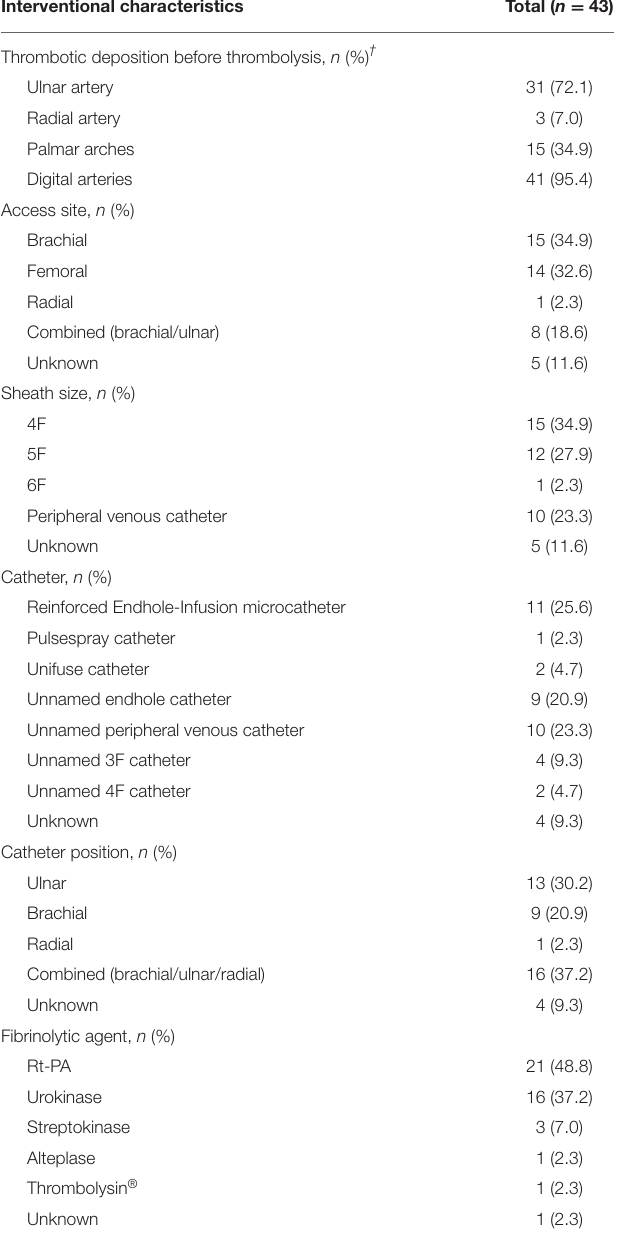
TABLE 3 | Patients’ interventional characteristics.